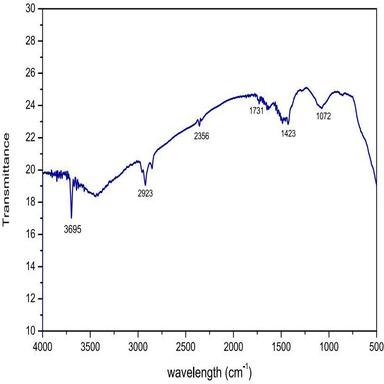
FTIR spectrum of RbCl doped MgO nanoparticles.